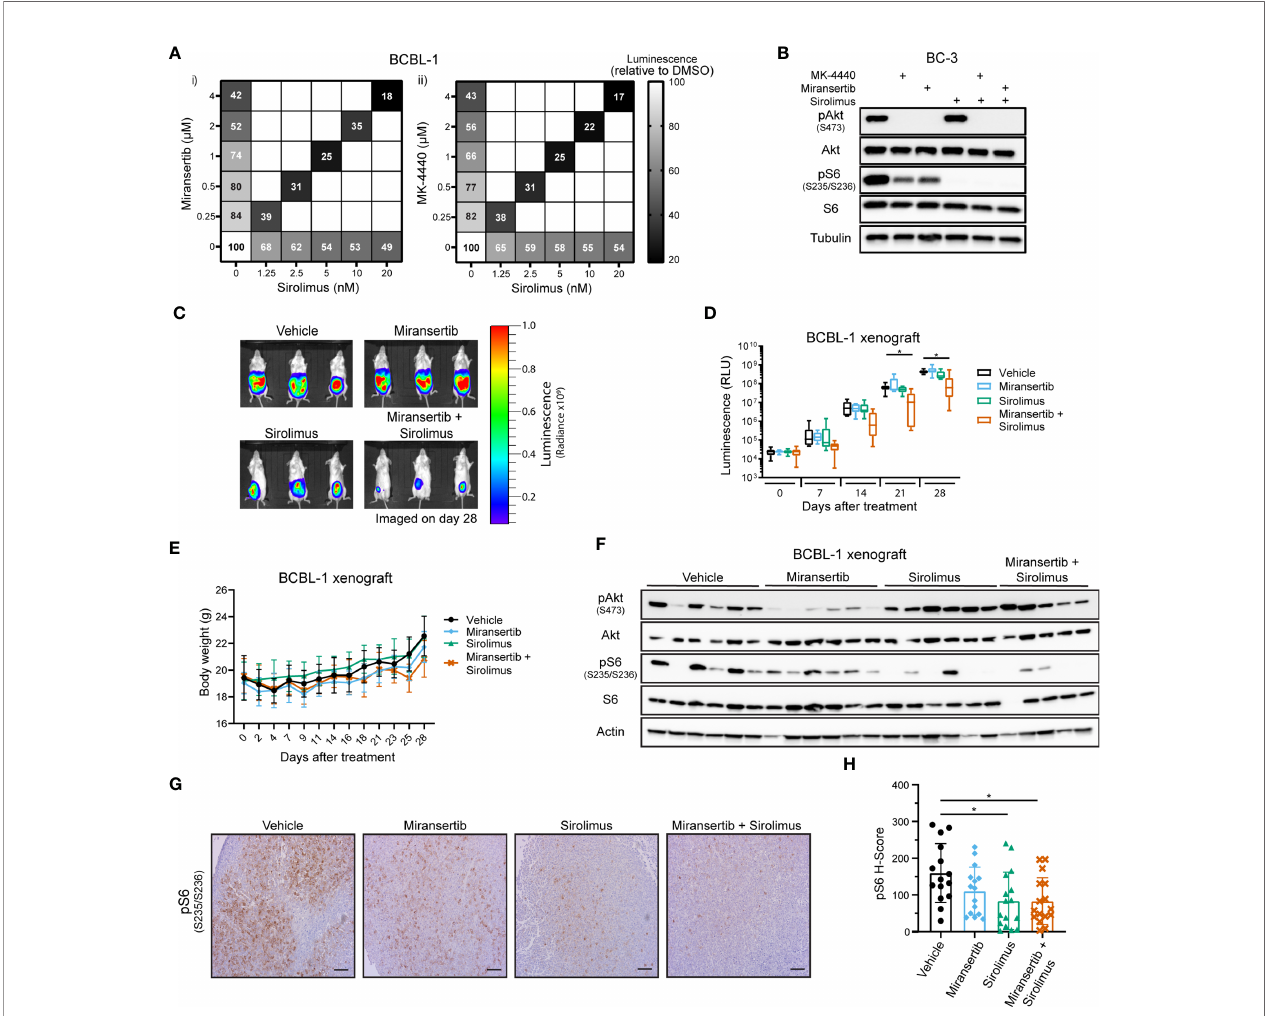
FIGURE 6 | Combined inhibition of Akt and mTORC1 is synergistic against primary effusion lymphoma cells. (A) BCBL-1 cells were treated with different doses of sirolimus alone or in combination with miransertib (i) or MK-4440 (ii). After 72 h, the percentage of viable cells was calculated using CellTiter-Glo, normalized to the DMSO (vehicle; 100%) control, and the heat-map depicts the effect on viability. darker color = lower luminescence = lower viability. (B) BC-3 cells were treated for 6 h with DMSO, MK-4440 (1.5 µM), miransertib (1.5 µM), sirolimus (5 nM), or the combination of the mTORC1 and Akt inhibitors. Lysates were prepared, and immunoblots were performed as in Figure 1C . (C) BCBL-1-Luc we intraperitoneally (i.p.) injected into NSG mice and treated with vehicle (n=6), 100 mg/kg miransertib (n=6), 0.375 mg/kg sirolimus (n=6), and 100 mg/kg miransertib + 0.375 mg/kg sirolimus (n=6) over a course of 4 weeks. The expression of luciferase was measured every Monday by i.p. injecting mice with luciferin. Representative images obtained on the 28 th day of treatment show the tumor burden. (D) The luminescence measured from (C) images was presented as a box and whiskers plot with the whiskers marking the minimum and maximum values. *p < 0.05 determined by two-way ANOVA. The p-values for all other comparisons were >0.05. (E) The body weight of mice was measured and recorded throughout the experiment. (F) Immunoblots were performed from protein extracted from the tumors collected at the end of the xenograft experiment shown on (C, D) . (G) Representative images of immunohistochemistry against pS6 (S235/6) performed to tumor sections as in Figure 2E . (Scale bars, 100 m m) (H) The H-score of pS6 was calculated from at least 15 frames per treatment group using HALO. *p < 0.05 determined by one-way